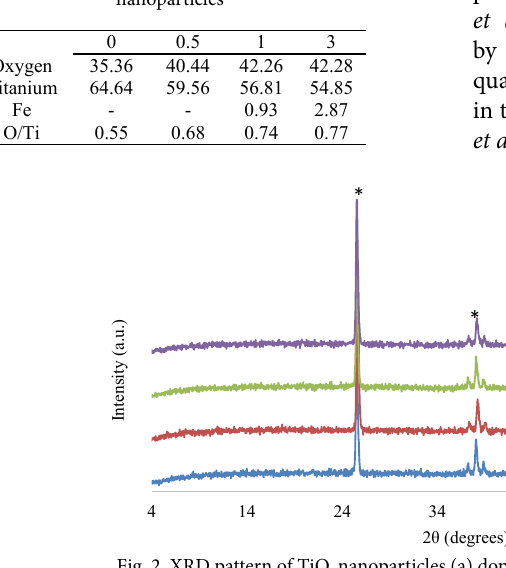
Fig. 2. XRD pattern of TiO nanoparticles (a) doped with 1 (b), 3 (c) and 5 % (d) Fe. 2 Figure 2. XRD pattern of TiO 2 nanoparticles (a) doped with 1 (b), 3 (c) and 5 % (d) Fe.